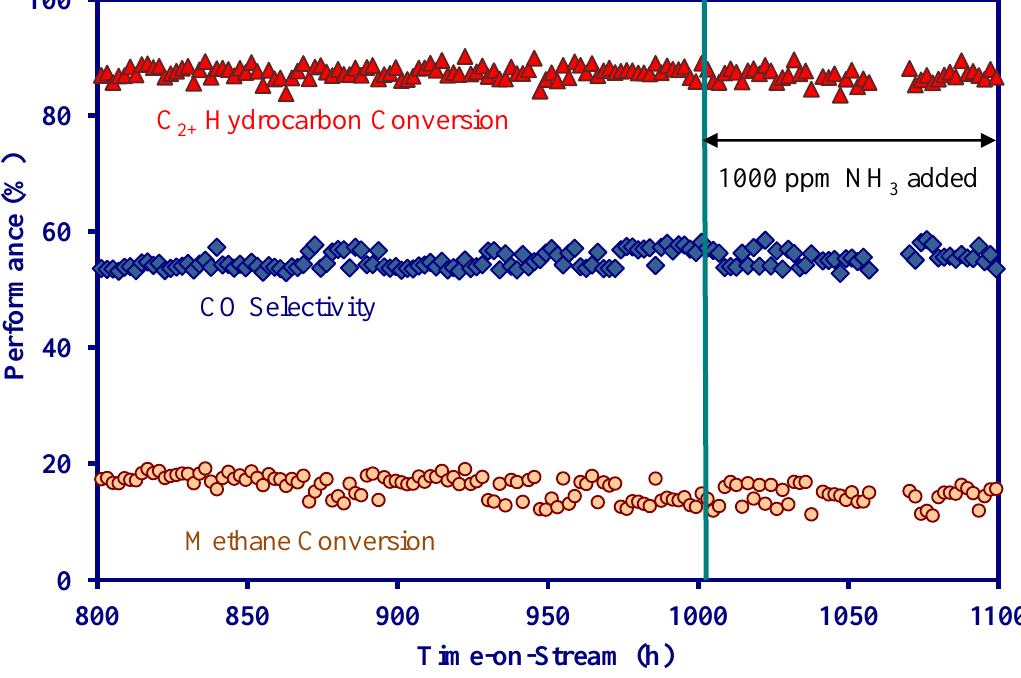
and H S under the conditions of 900 °C, 3 2 , 10.4% CO, 9.8% CO , 5.8% CH , 13.2% N 2 2 4 H and C H , 0.2% C H and C H , 1000 ppm NH (when used) and 2 6 2 4 3 8 3 6 3